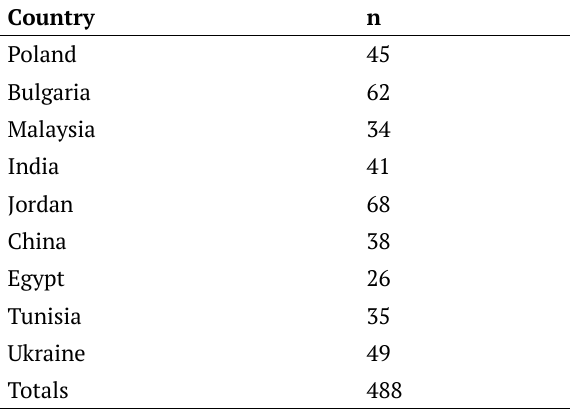
Table 1. Distribution of study